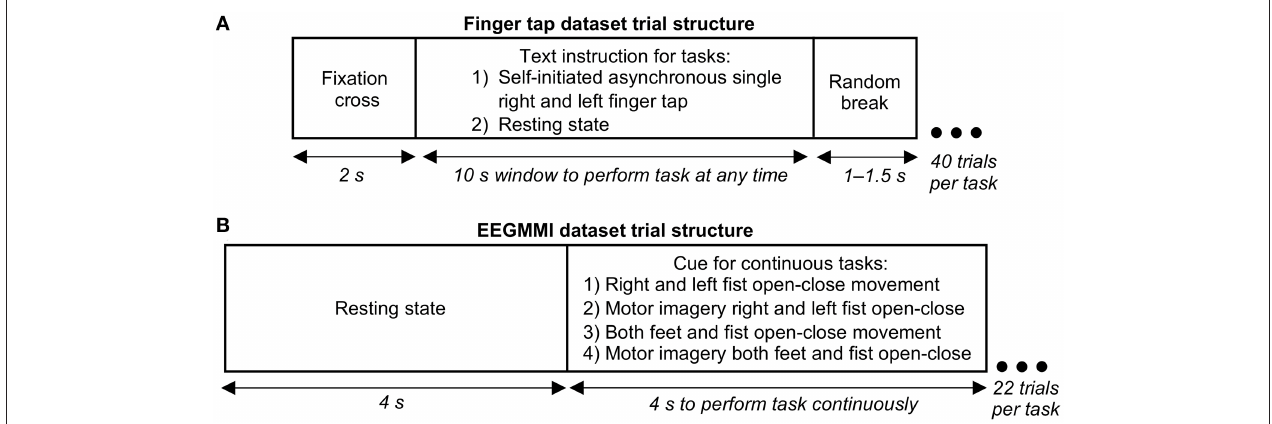
FIGURE 1 | Structure of a single electroencephalography (EEG) trial in our finger tapping dataset and EEG Motor Movement/Imagery Dataset (EEGMMI) dataset. (A) Trial structure for single self-initiated asynchronous finger tap. Participants were given a window of 10 s to perform a single tap any time, or if it was a resting state task, they were asked to remain still with eyes open without thinking of movement. (B) Trial structure for four cued EEGMMI tasks, including continuous movement or motor imagery for 4 s of single or both fists and both feet.